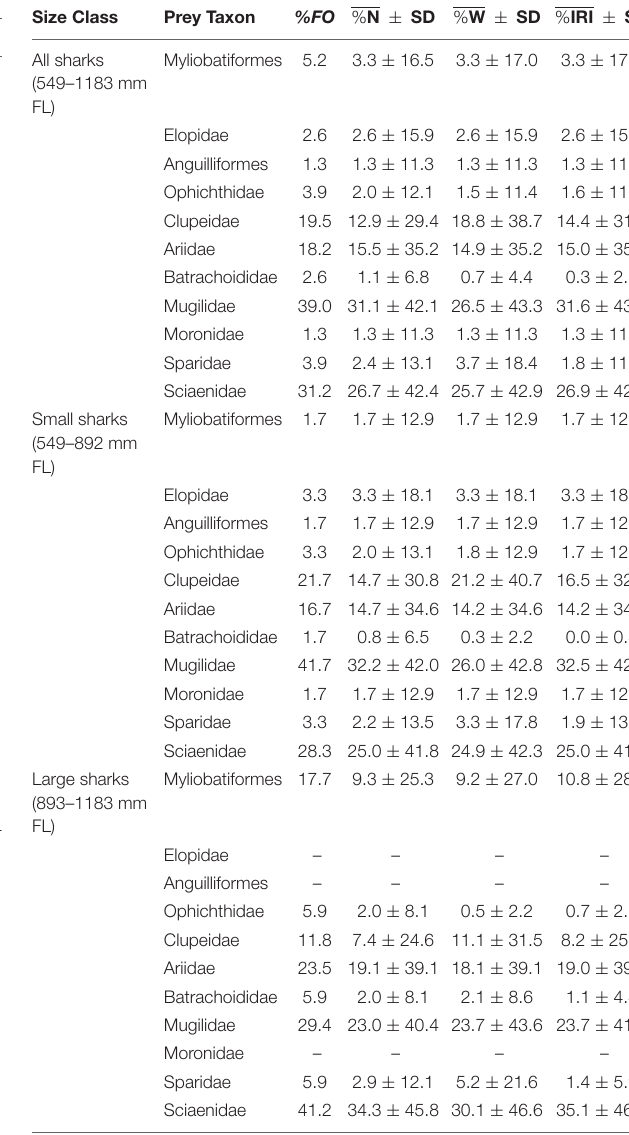
TABLE 2 | Contributions of fish prey identified to family (or higher, where family-level identification was not possible) to the diet of bull sharks ( Carcharhinus leucas ) from nwGoM